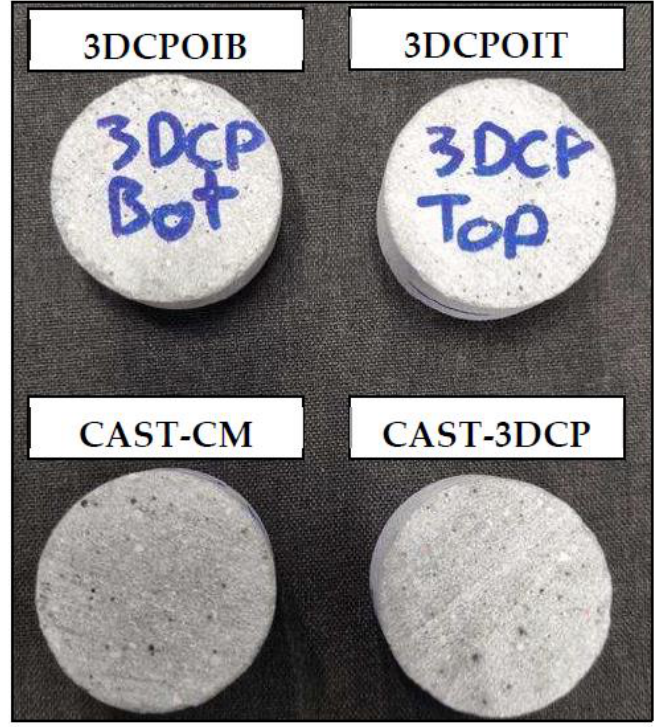
Figure 4. Core-drilled specimens of 20 mm height and 30 mm diameter for μ -CT scanning.